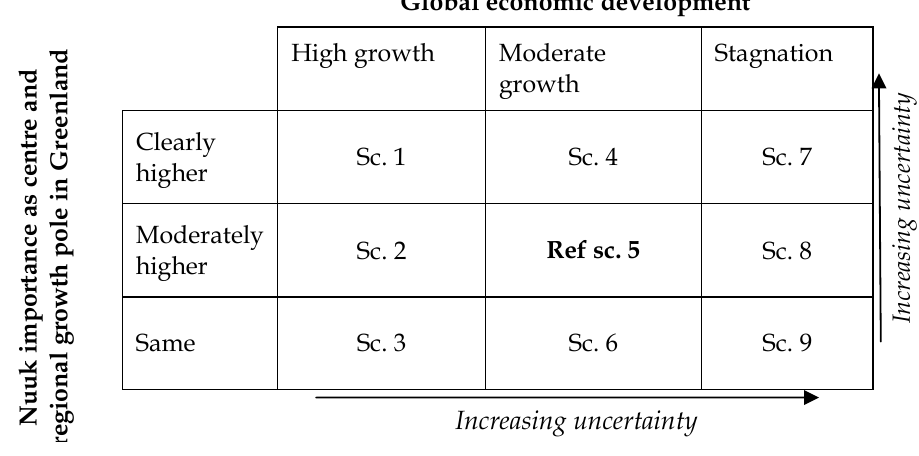
Figure 4. Scenarios for imagined futures representing possible and plausible